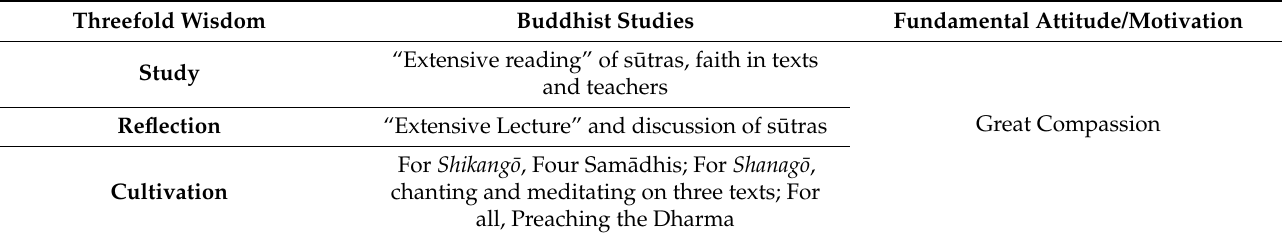
Table A2. Table organizing the curriculum according to three